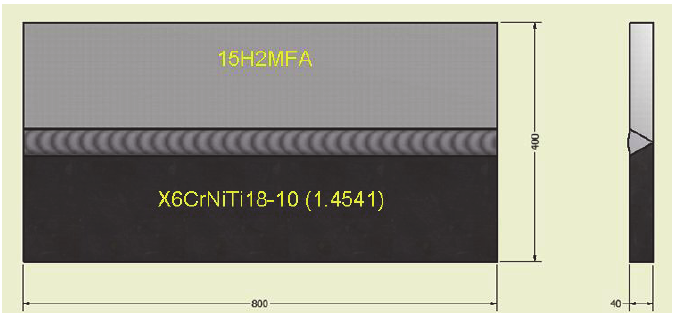
Figure 2: Dimensions of the specimen.